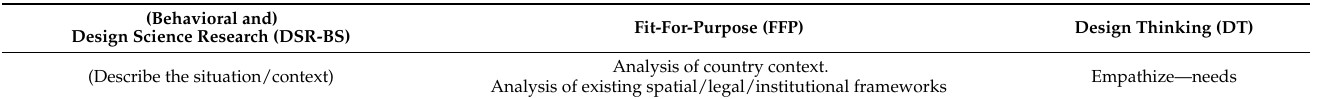
Table 4. Extract of context